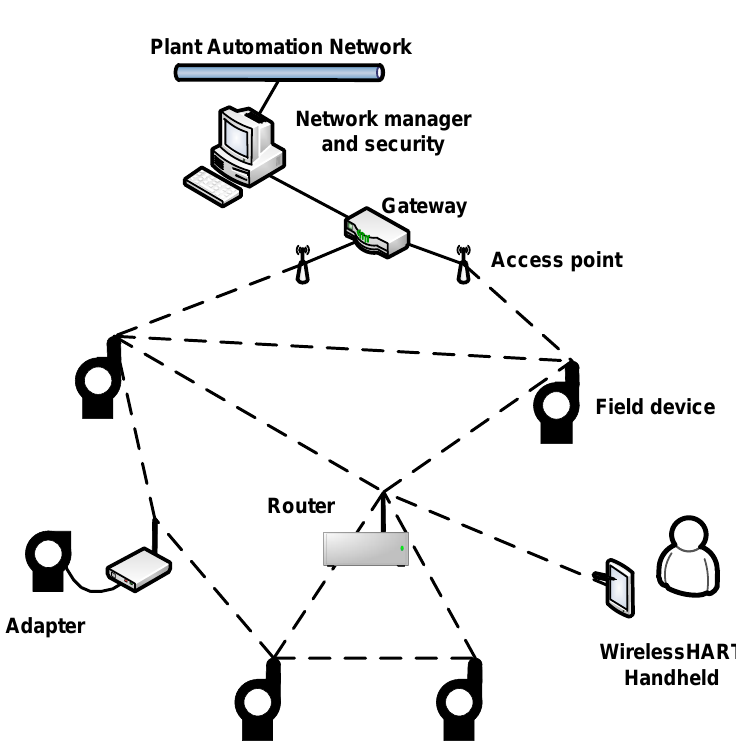
Figure 1. WirelessHART